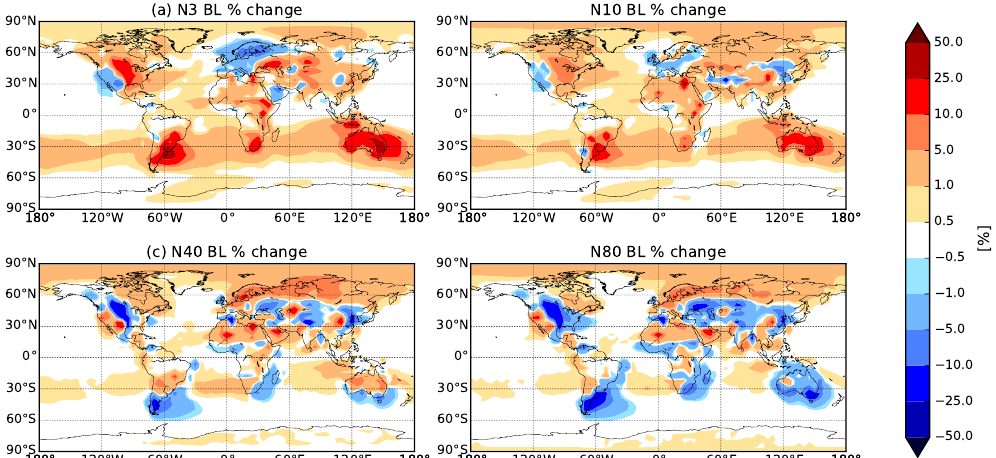
Figure 6. Percentage change in annually averaged boundary layer (a) N3, (b) N10, (c) N40, and (d) N80 when changing MEGAN BVOC emissions from year 1000 to year 2000 with anthropogenic emissions off (BE2.AEO.meg–BE1.AEO.meg). Globally averaged, N3, N10, and N40 increased by 3.2, 1.9, and 0.4%, respectively, whereas N80 decreased by 0.6% (see Table 2). An increase in particle number concentration is represented in red, and a decrease in